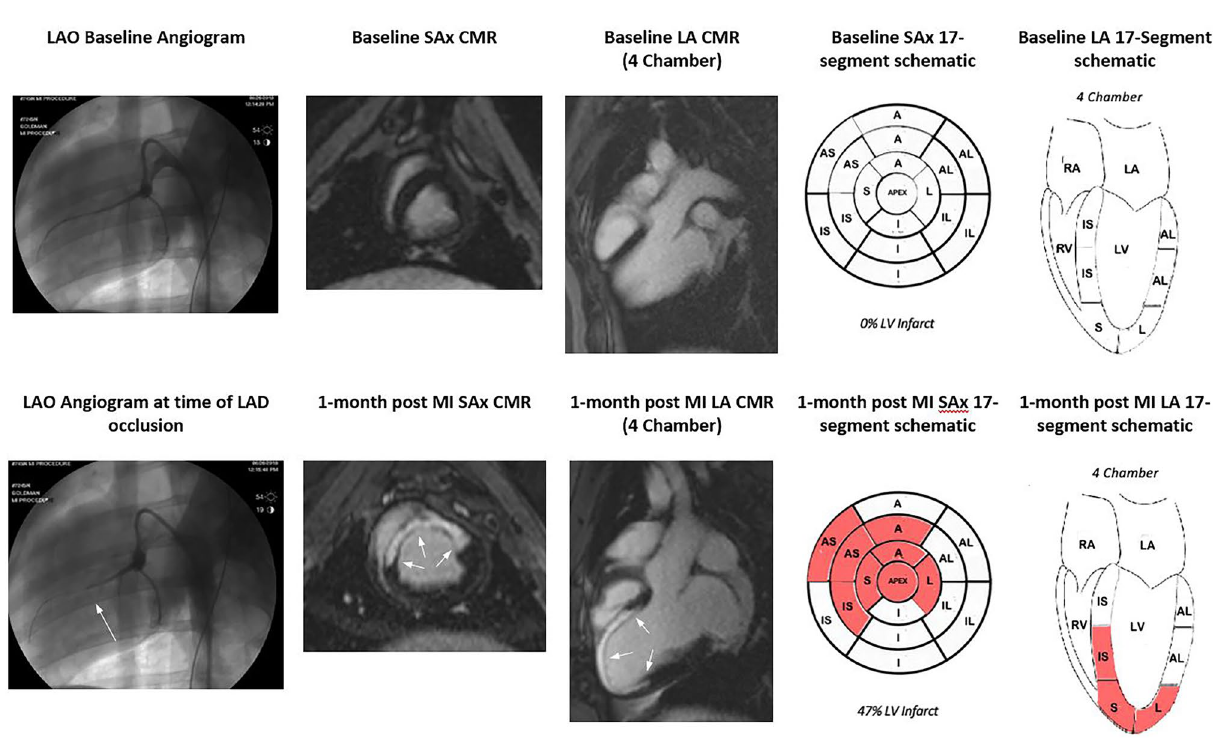
Figure 3. The images on the top row show pre-infarct (baseline) angiography, SAx CMR, LA 4 chamber CMR, SAx 17-segement schematic, and LA 4 chamber 17-segment schematic (from left to right). The images on the bottom row show angiography after occlusion of the LAD just distal to the first diagonal branch and 1-month post MI images of SAx CMR, LA 4 chamber CMR, SAx 17-segement schematic, and LA 4 chamber 17-segment schematic (from left to right). In the 17-segment schematics, the letters denote different anatomical areas of the heart with AS anteroseptal, IL inferolateral, A anterior, I inferior, IS inferoseptal, AL anterolateral. The 17-segment SAx wheel shows the apex at center most portion of the wheel and the base segments at the outermost portion of the wheel. Quantification of myocardial ischemic injury is shown in red. Average infarct percent volume (%) is denoted below the 17-segment